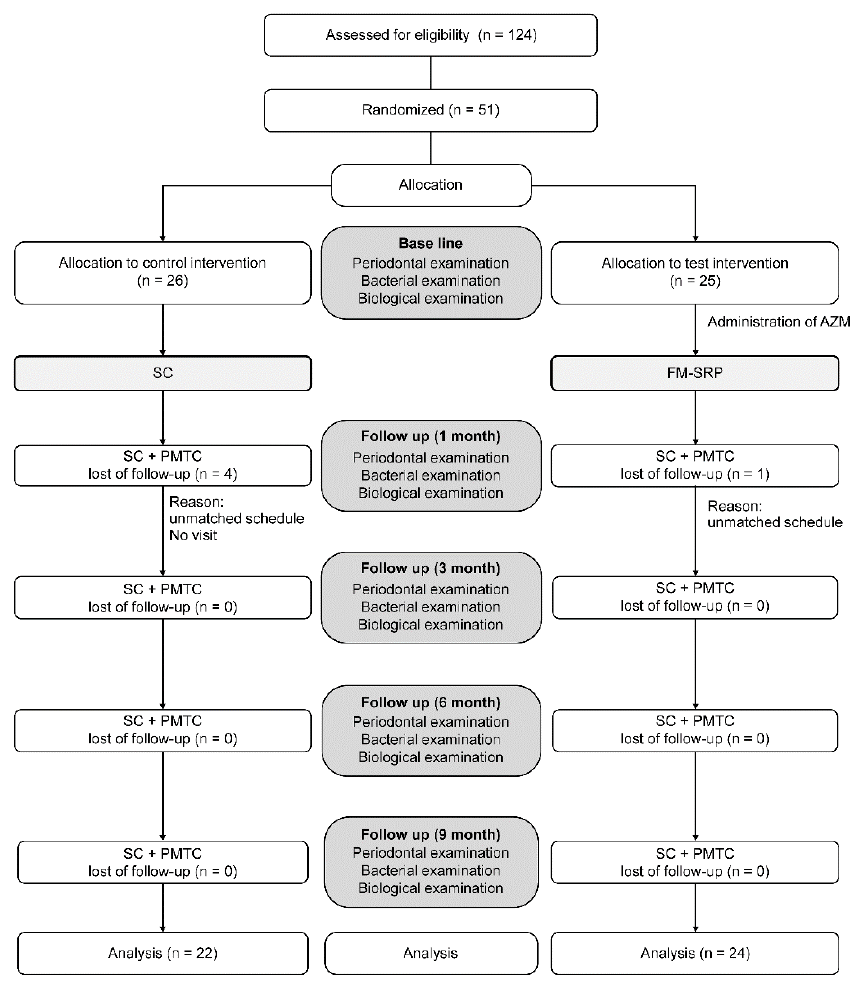
Figure 1. Study design flowchart.